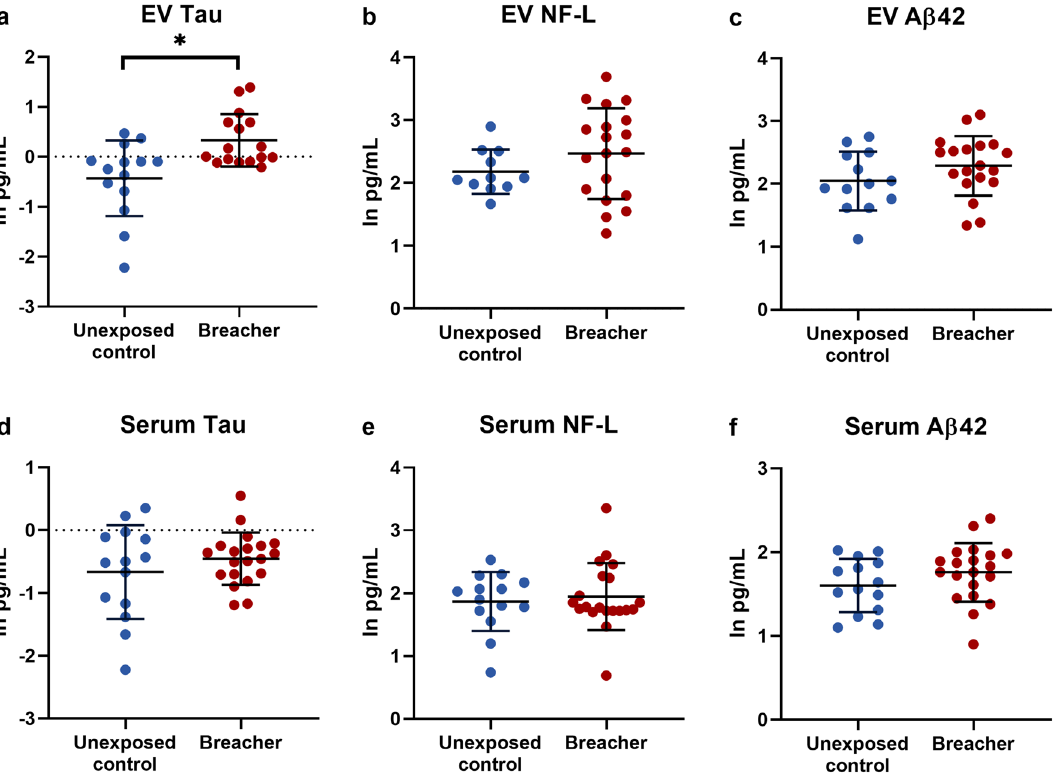
Figure 1. Neuronal-derived EV tau distinguishes experienced breachers from controls. (a) Exosomal tau was elevated in the experienced breacher group compared to the control group. There were no statistically significant changes in EV levels of (b) NF-L or (c) Aβ42. There were no statistically significant changes in serum levels of (d) tau, (e) NF-L, or (f) Aβ42. *indicates p < 0.05, error bars represent the mean and SD. NF-L neurofilament light, Aβ amyloid-beta.